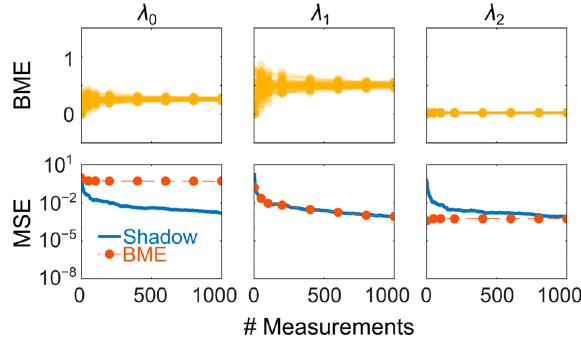
Fig. 5 Bayesian inference results employing the psuedo- likelihood in Eq. (11), for D = 32. The shadow MSE values from Fig. 1 are reprinted for